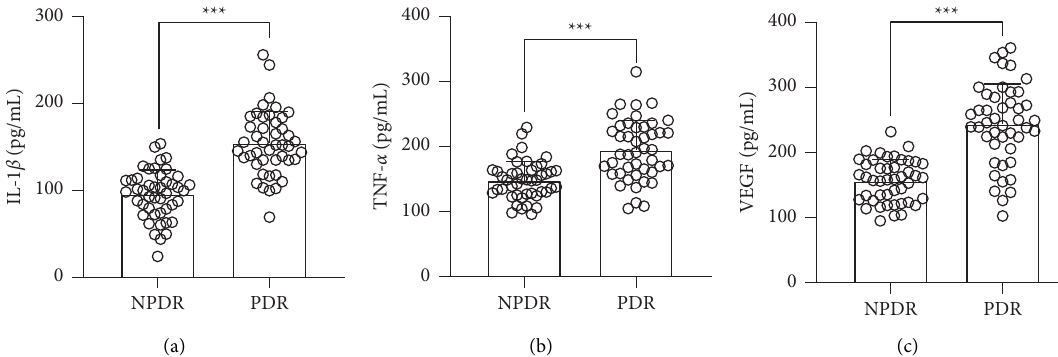
Figure 2: Comparisons of serum IL-1 β (a), TNF- α (b), and VEGF (c) between NPDR and PDR patients. N � 45 for each group. Unpaired t - test. ∗∗∗ p < 0 .